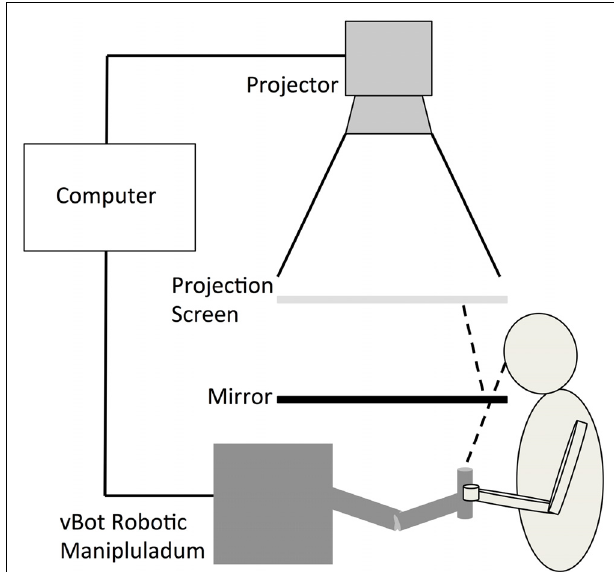
FIGURE 1 |The experimental set-up was similar to that described in Preston etal. (2010). Participants viewed the cursor via a horizontal mirror that was positioned equidistant between the limb and projection screen such that visual feedback of their movements appeared in the same spatial plane as the actual reaching